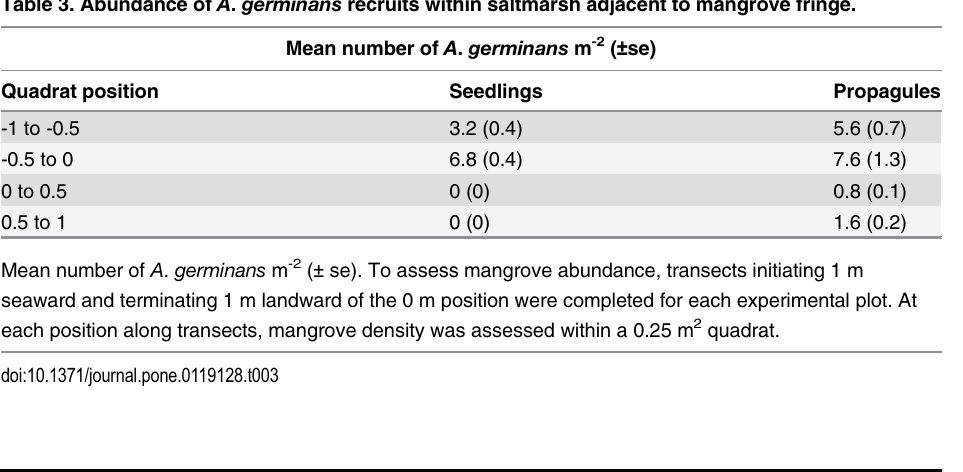
Table 3. Abundance of A . germinans recruits within saltmarsh adjacent to mangrove fringe.